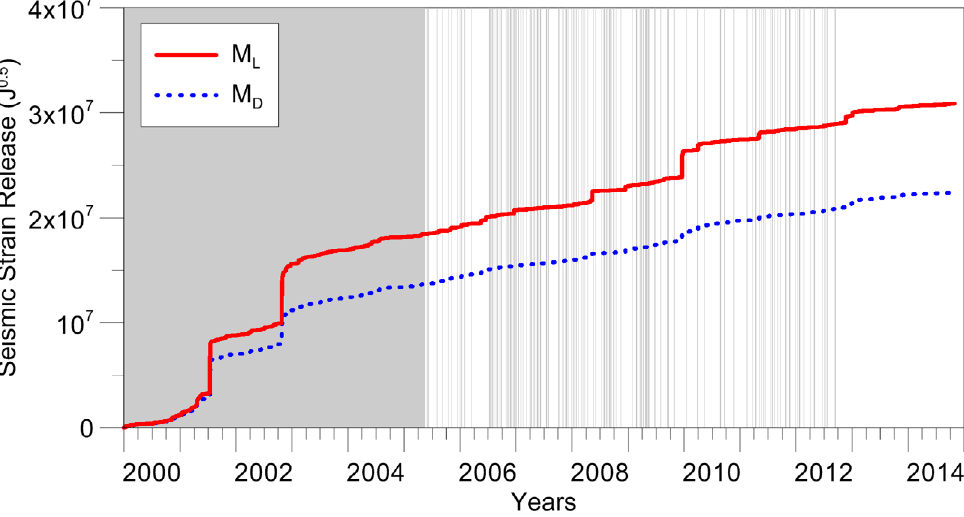
Figure 7. Cumulative seismic strain release of Mt. Etna volcano from 2000 to 2014 calculated using the Richter [1958] relationship. Dotted blue line for M dataset and red line for observed or calculated M D